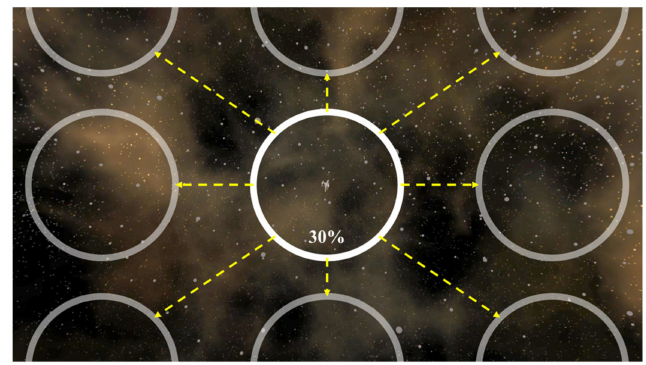
Figure 5. The fifth VR sickness reduction method